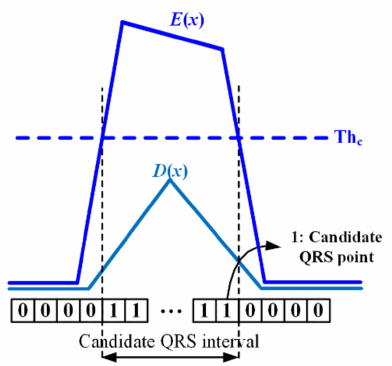
Figure 4. Candidate-R section in the enhanced residual